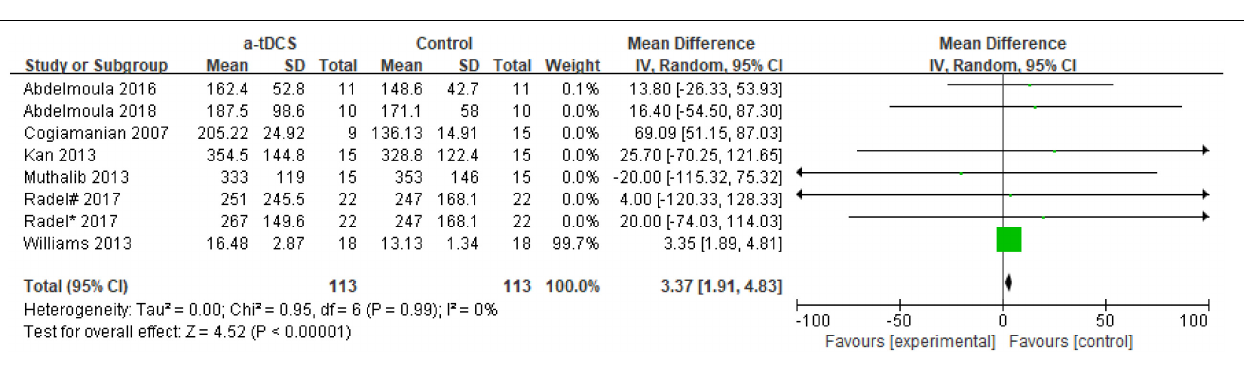
FIGURE 5 | Forest plot of sensitivity analysis of the effect of a-tDCS for enhancing upper limb muscle